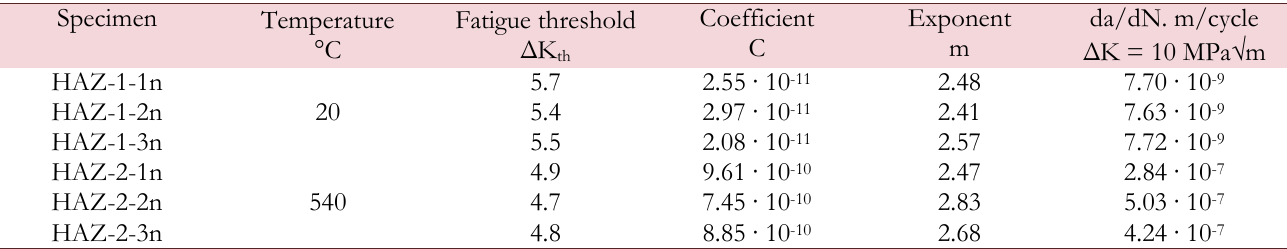
Table 8: Fatigue crack growth parameters for specimens with notches in new HAZ.